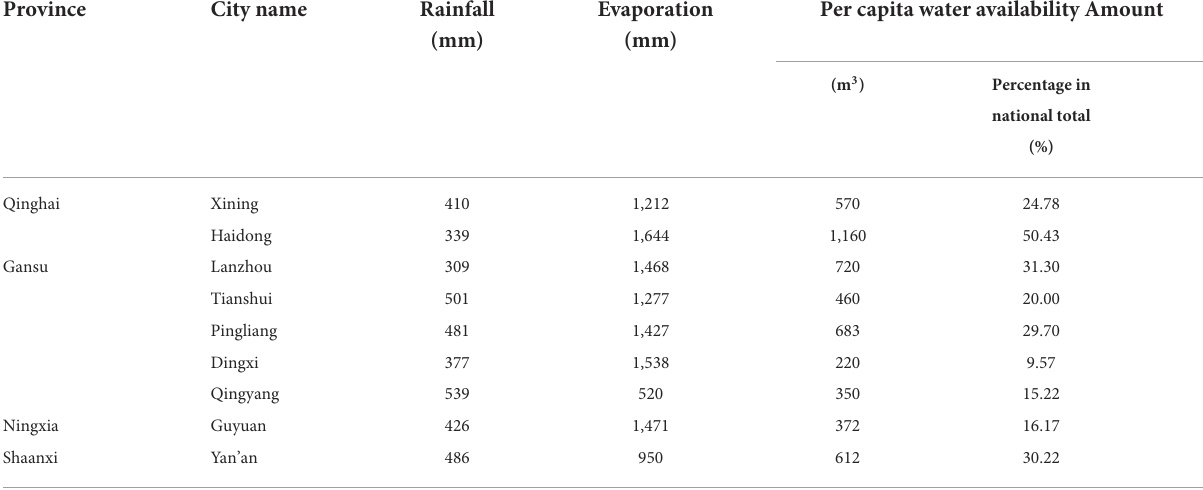
TABLE 1 Statistics of rainfall characteristics and per capita water availability in some cities in northwestern China.